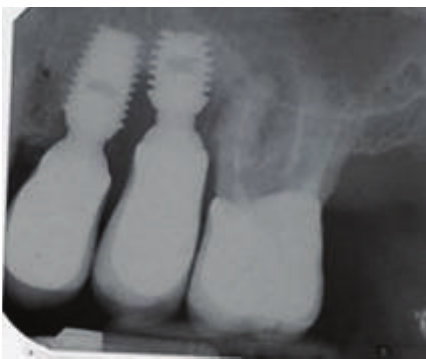
Figure 3: After elevation of the vestibular and palatal full thickness flaps, a crater-like defect characterized by interproximal bone loss was observed around the implants.